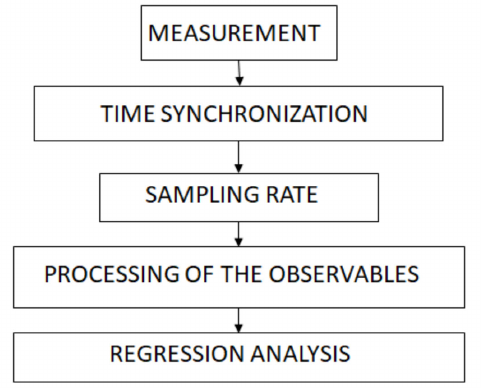
Figure 2. The data processing: synchronised data are resampled and processed before being statisti- cally